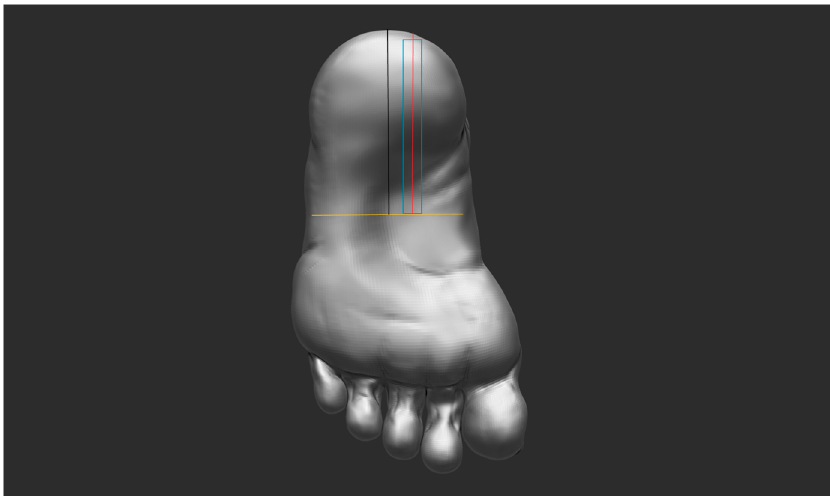
Figure 1. Image showing protocol for standardization of transducer head placement with yellow line marking the width of the sole of the foot at a point aligned parallel with the navicular tuberosity; black line marking the midpoint of the sole of the foot; red line marking placement of middle of transducer probe 1 cm medial to the middle of the foot; the blue outline shows the total surface area of the plantar surface of foot in contact with transducer head.